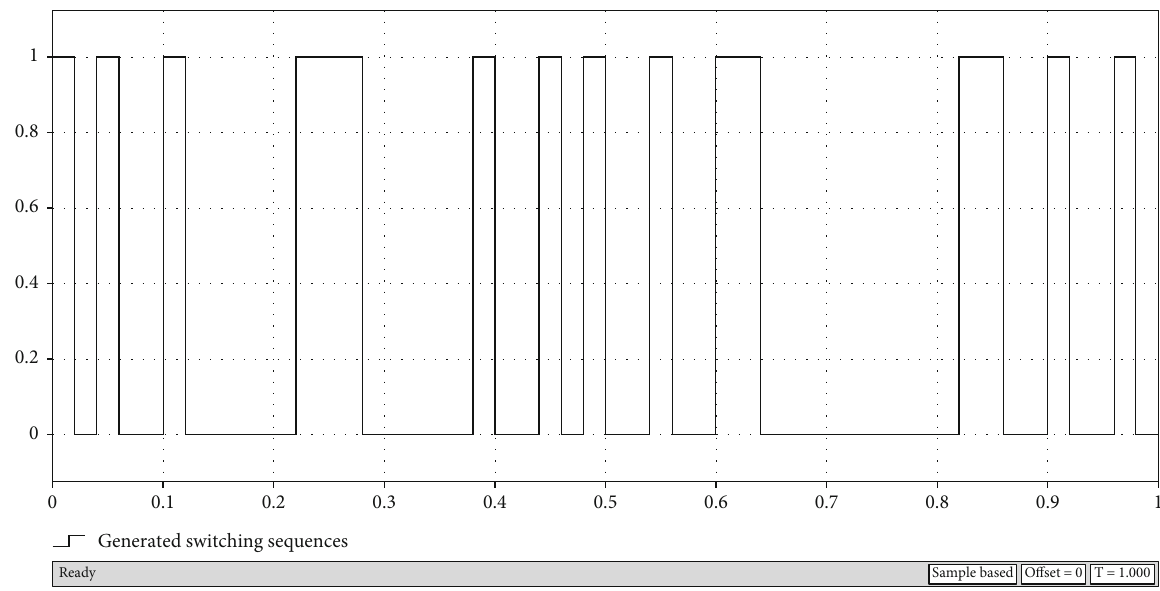
Figure 22: Generated pulses for the K